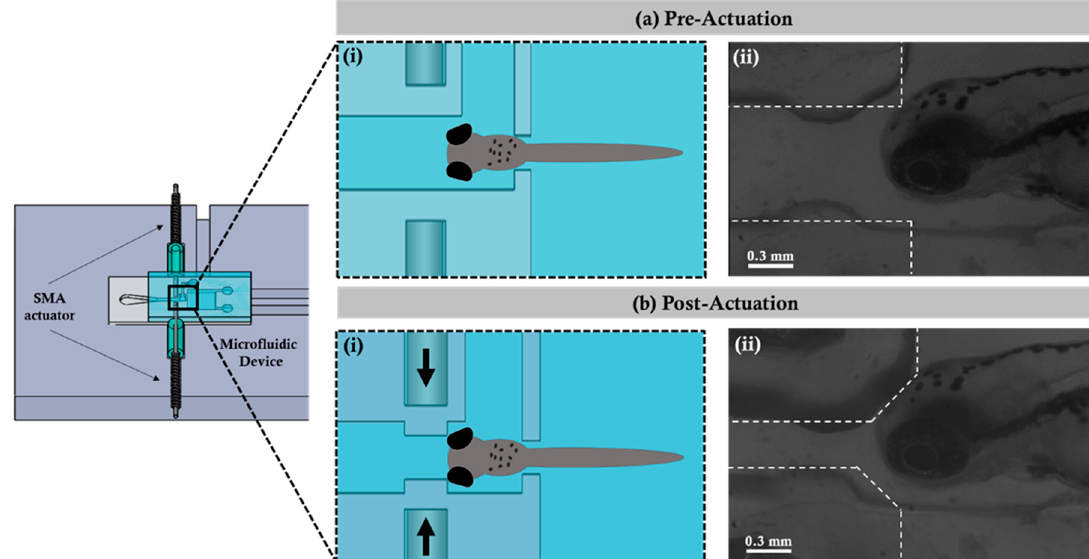
Figure 2. Illustration of the microfluidic device actuating operation using the SMA. ( a ) ( i ) and ( b ) ( i ) are the pictorial illustrations of the microfluidic device before and after the actuation process. ( a ) ( ii ) and ( b ) ( ii ) are the microphotographs captured before and after the actuation process.